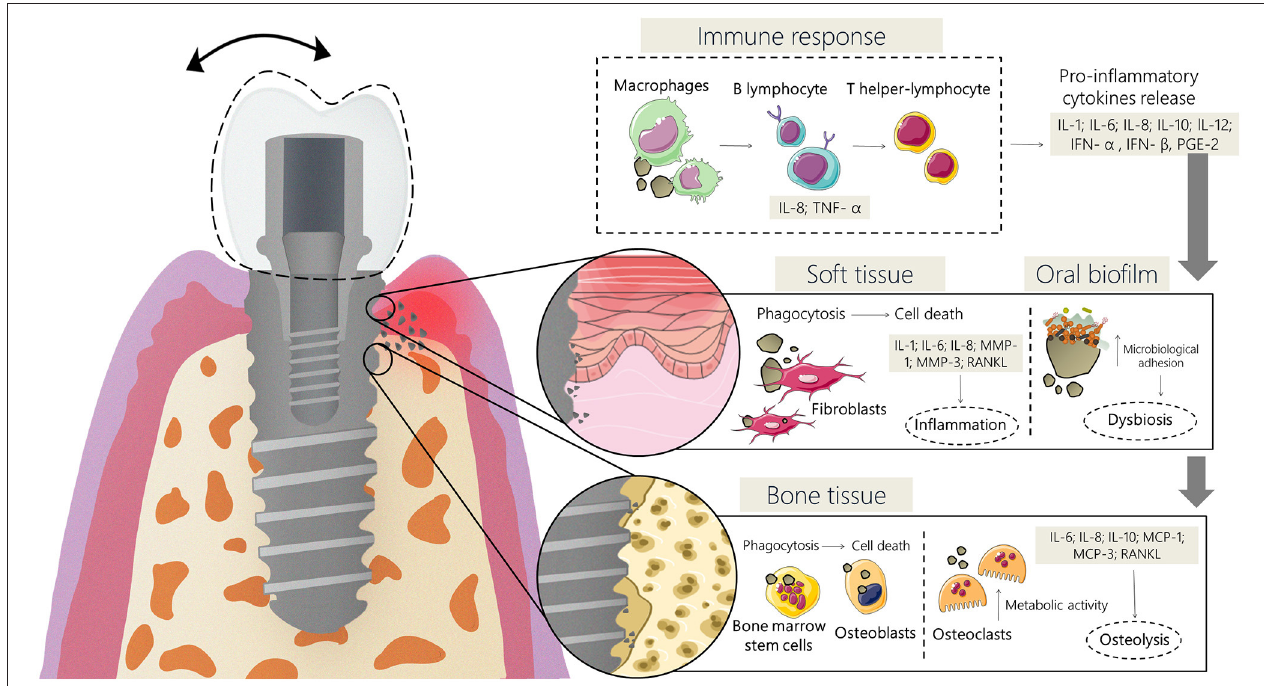
FIGURE 3 | Schematic representative diagram of the inflammatory process induced by Ti wear particles. This process causes the activation of immune-system cells (monocytes, macrophages, neutrophils, and T lymphocytes) with the release of pro-inflammatory cytokines, such as TNF- α , IL-1 α , 1 β , IL-6, IL-10, and prostaglandin (PGE2) which leads to damages in the epithelial barrier, facilitating bacterial colonization, increasing the inflammatory, and infectious reactions.